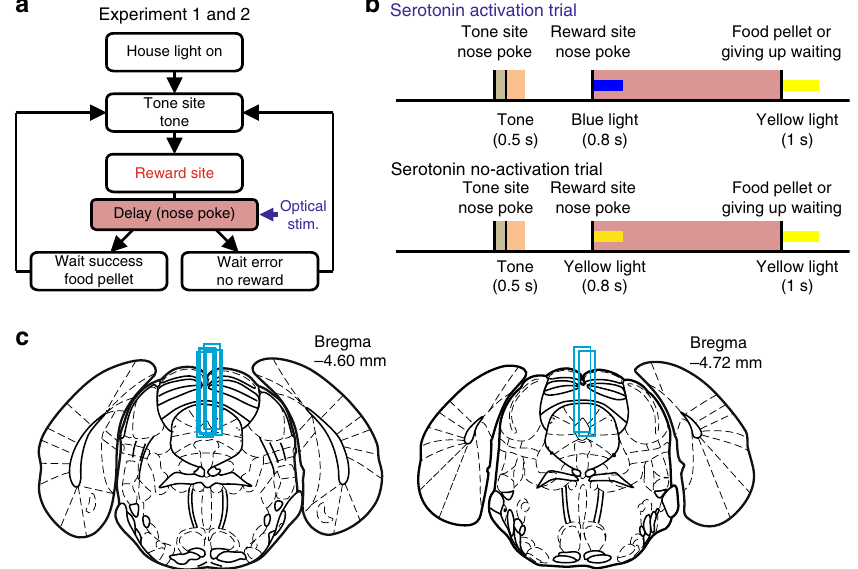
Fig. 1 Schematic of the sequential tone-food waiting task. a Diagram of the test in which optogenetic stimulation was applied during the reward-delay period (experiments 1 and 2). b Time sequence of serotonin activation trials and serotonin no-activation trials. In serotonin activation trials, 0.8 s of blue light was delivered at the onset of the reward delay. In serotonin no-activation trials, 0.8 s of yellow light was applied at the onset of the reward delay. In each trial, 1 s of yellow light was used at the onset of food presentation or at the reward wait error. Blue and yellow bars denote blue and yellow light stimulation, respectively. Brown- and red-shaded regions denote tone- and reward-delay periods, respectively. Orange-shaded regions denote duration of tone presentation. c Locations of optical fi bers in the DRN. Light blue bars in the DRN represent tracks of implanted optical fi bers. Coronal drawings were adapted from ref. 48 with